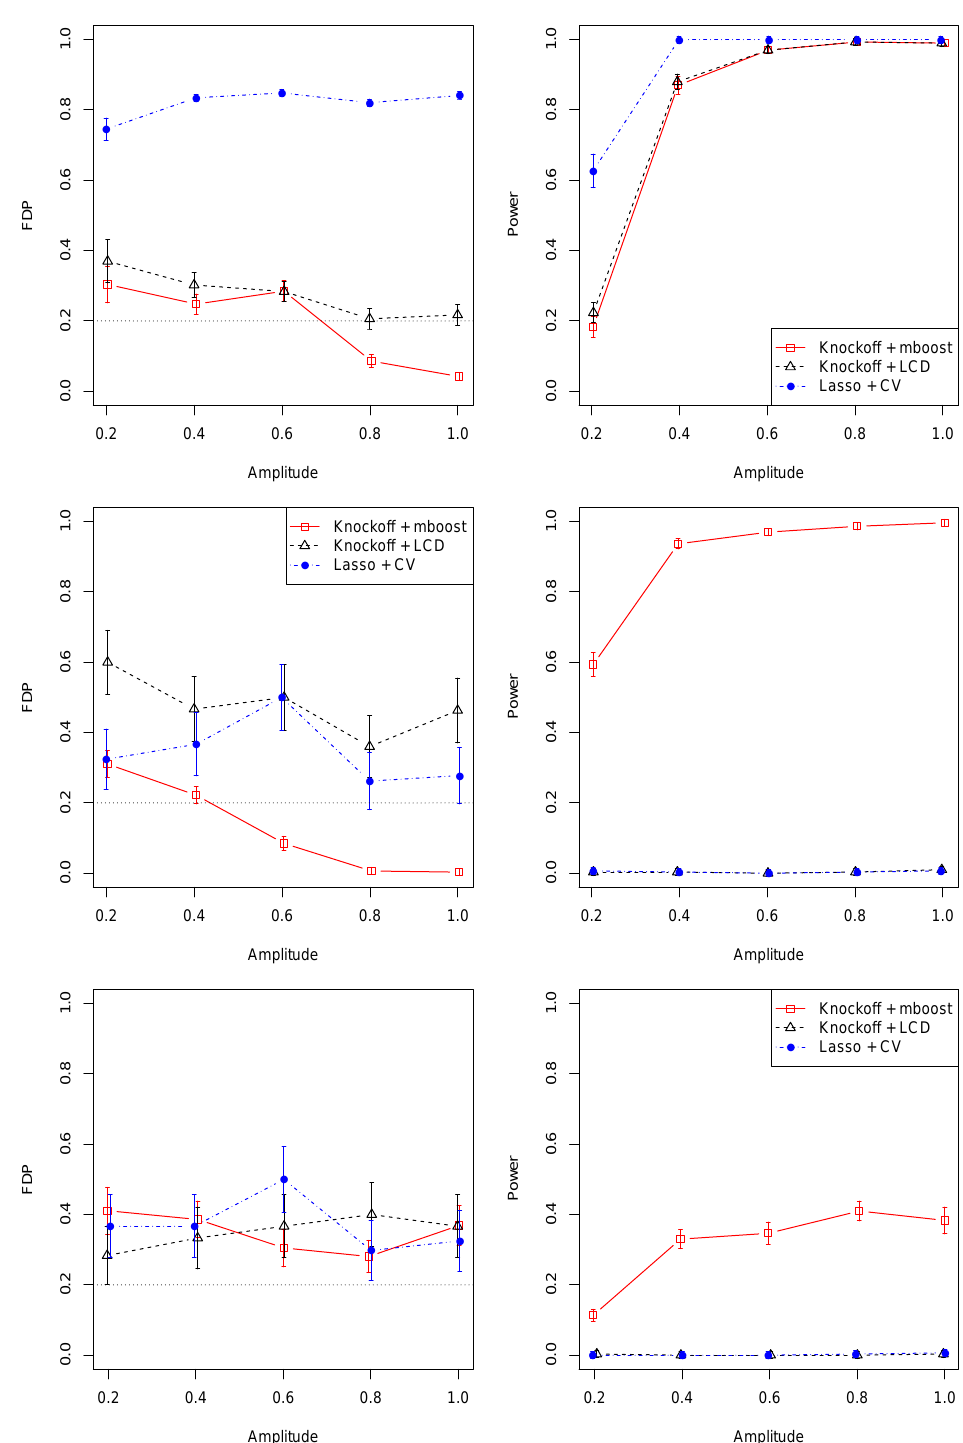
Figure 1. Simulation results for linear associations ( top panel ), nonlinear associations ( middle panel ) and survival analysis ( bottom panel ). Left panel: averaged false discovery proportion (FDP, the empirical version of FDR) and the standard error bars for knockoff variable selection with mboost (red), lasso coefficient difference (LCD) (black) and lasso regression with cross-validation (CV) (blue) as a function of amplitude (association strength (e.g., correlation) between a biomarker and the outcome) based on 30 simulation replications. The reference lines indicate the target false discovery rate of 20%. Right panel: corresponding empirical statistical power of the three methods.